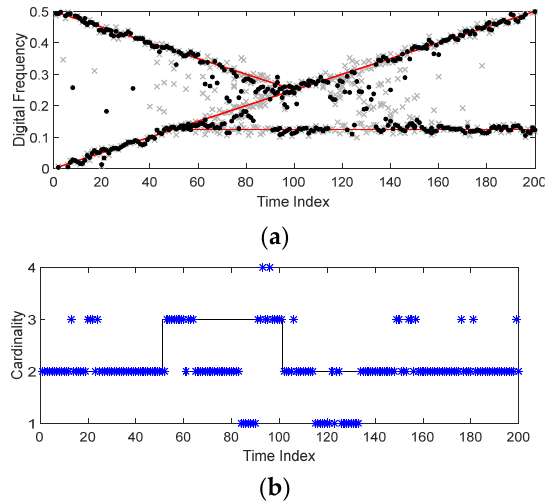
Figure 8. The result of the C_CPHD (case 2): ( a ) Frequency tracking; ( b ) Cardinality estimate.